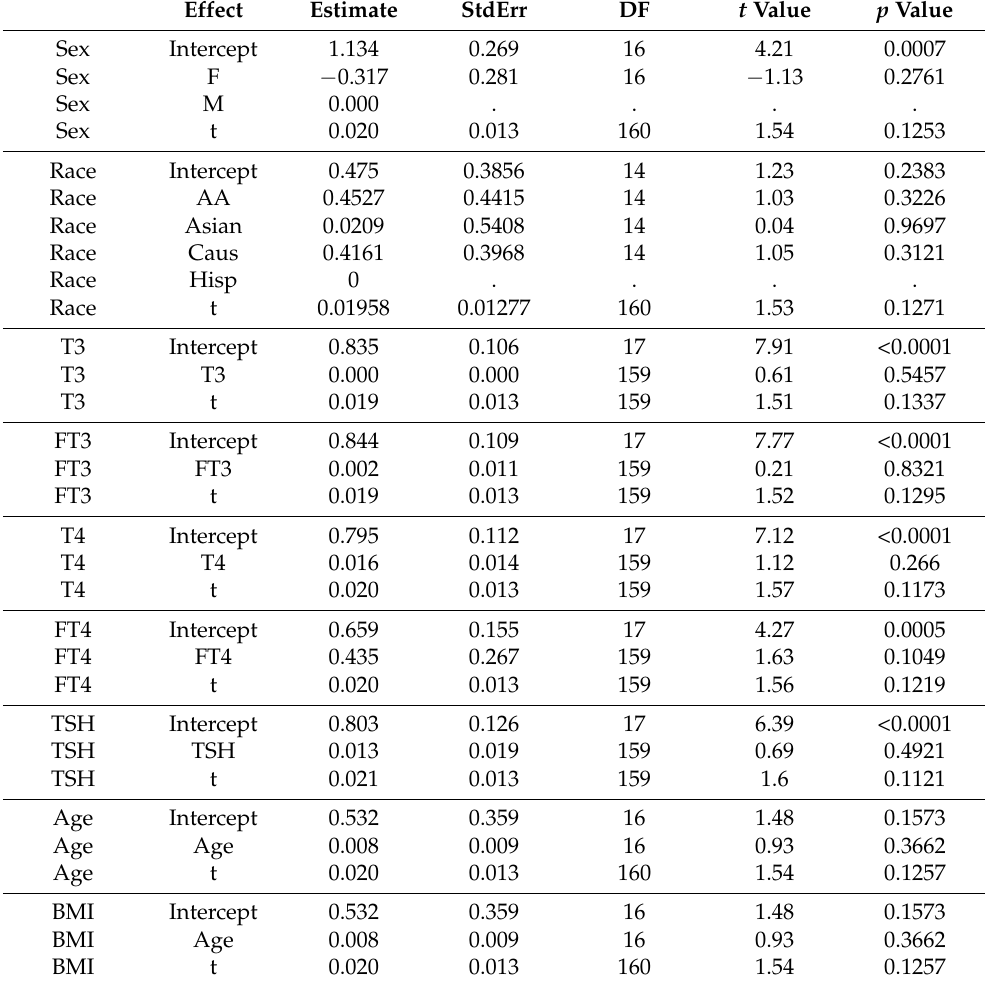
Table A5. Analysis of 3,5-T2 levels: Participants with hypothyroidism, hourly.